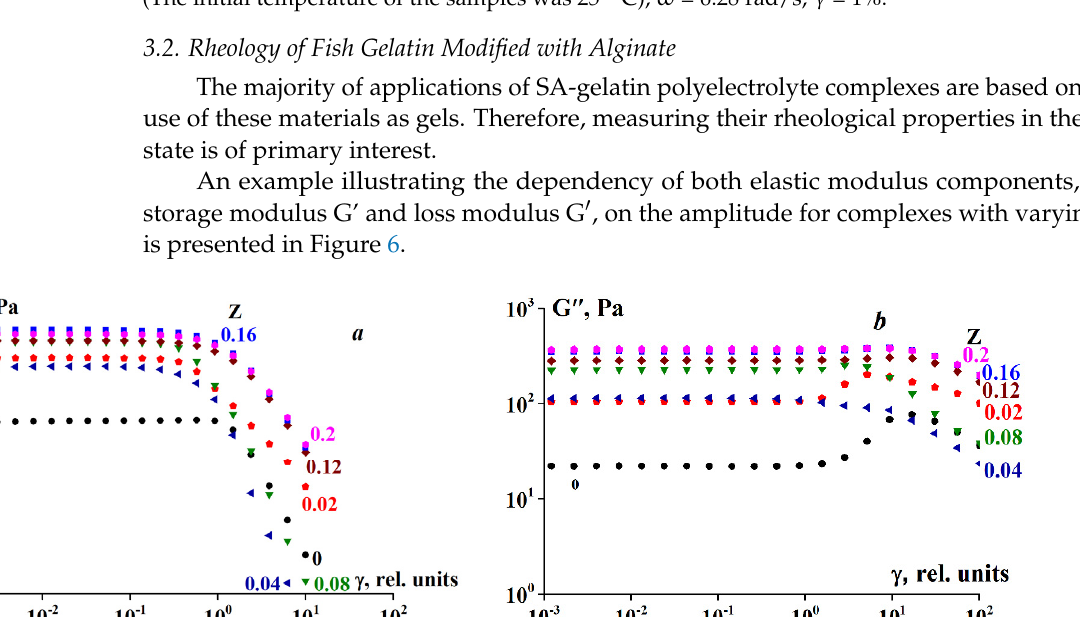
Figure 6. ( a ) Storage and ( b ) loss moduli dependency on amplitude at 4 ° С . ω = 6.28 rad/s. Gelatin concentration 10 wt.%. Z values are shown on the curves.